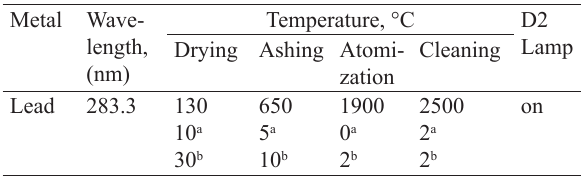
D2 LampTemperature, °CWave-